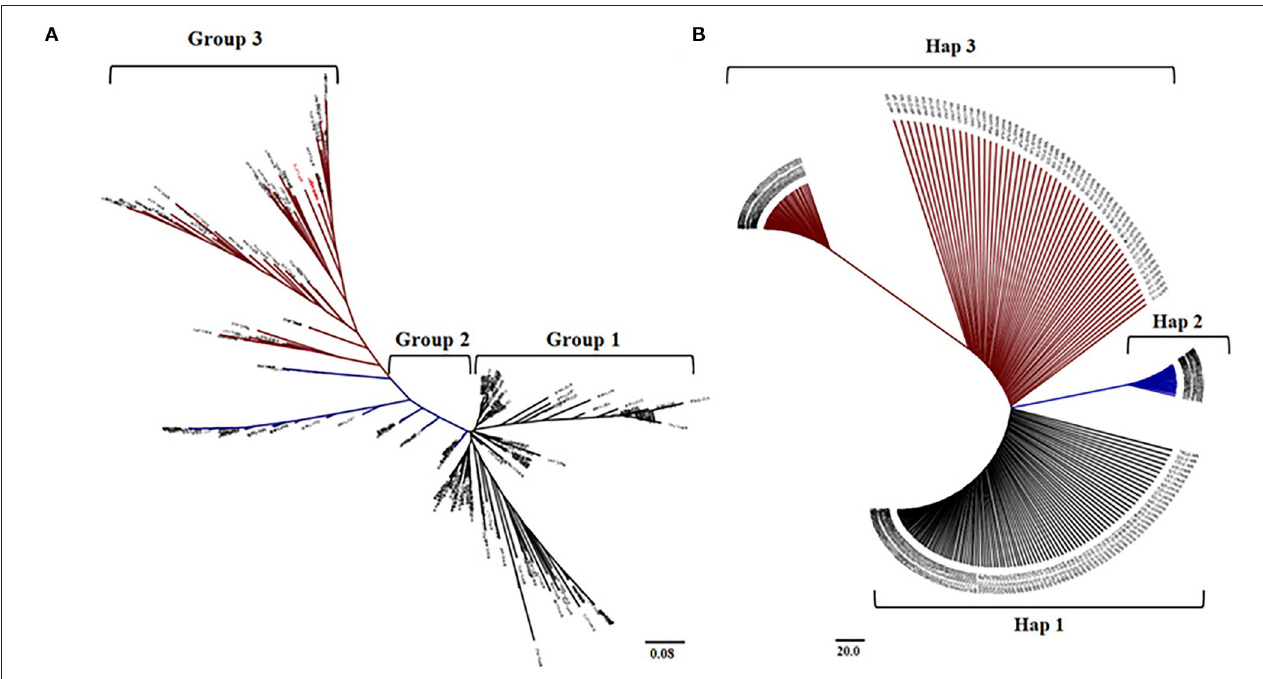
FIGURE 7 | Comparison between haplotype group and cis-eQTLs of AIR2. (A) Neighbor-joining tree and clustering groups for 273 accessions at the cis-eQTLs associated with AIR2 expression levels. (B) Neighboring binding trees and haplotype groups of 273 accessions to the genomic sequence of